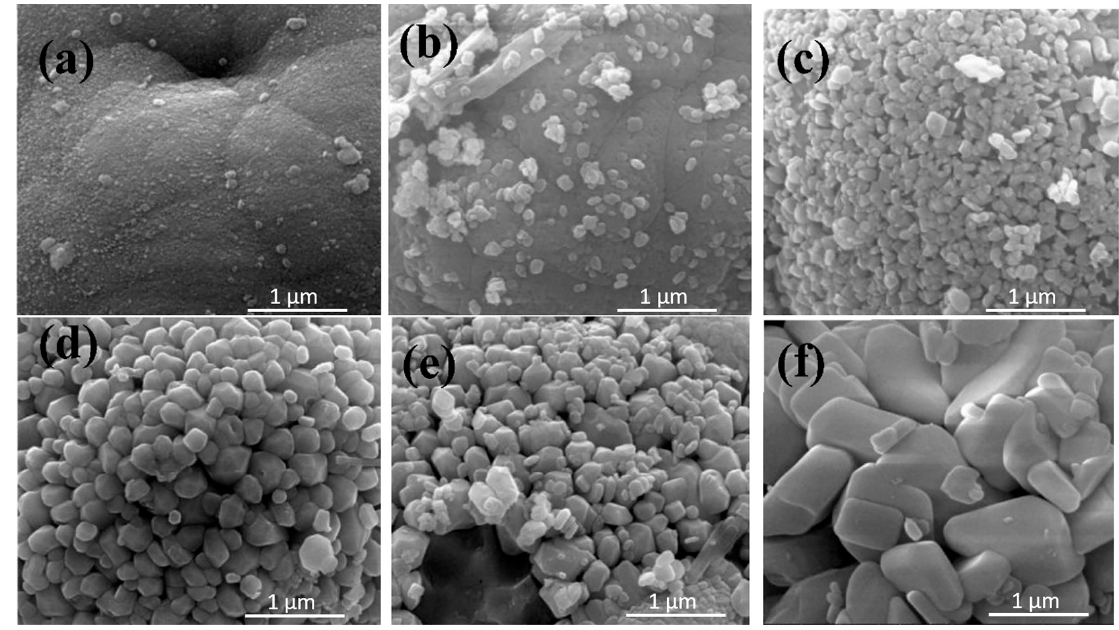
Figure 4. SEM maps of the BiVO 4 prepared at different hydrothermal times with an observation diameter of 1 μ m: ( a ) 0, ( b ) 3, ( c ) 6, ( d ) 12, ( e ) 14, ( f ) 24 h. Table 2. Related physical properties of the BiVO 4